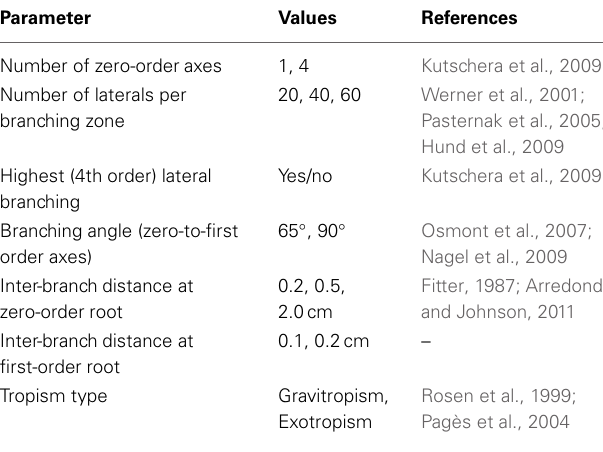
Table 1 | Parameters and values used for simulating different root